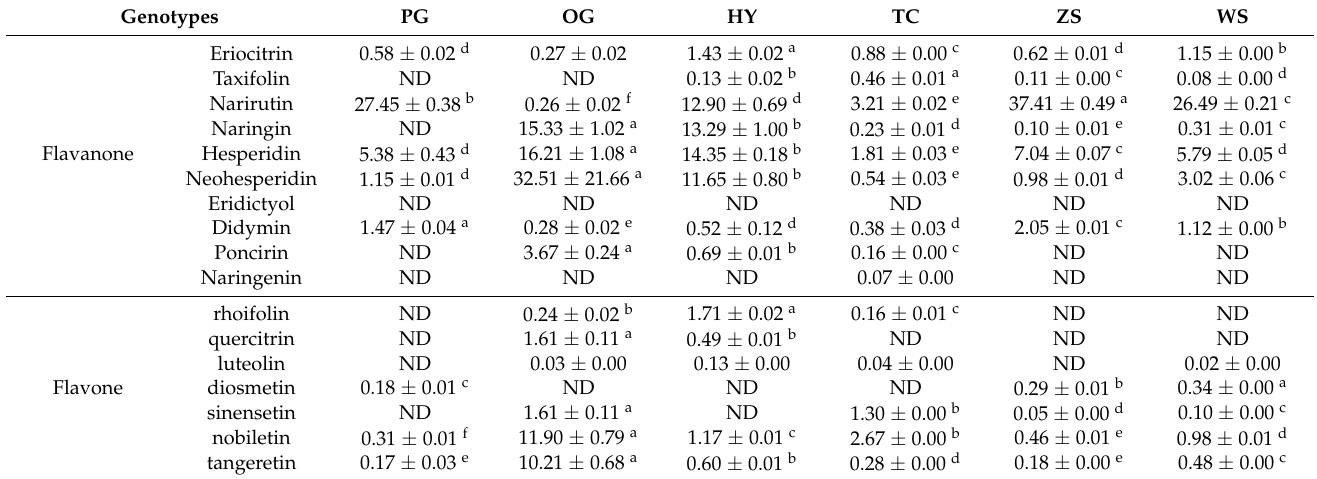
Table 2. Flavanone and flavone contents in young fruits of citrus (mg/g